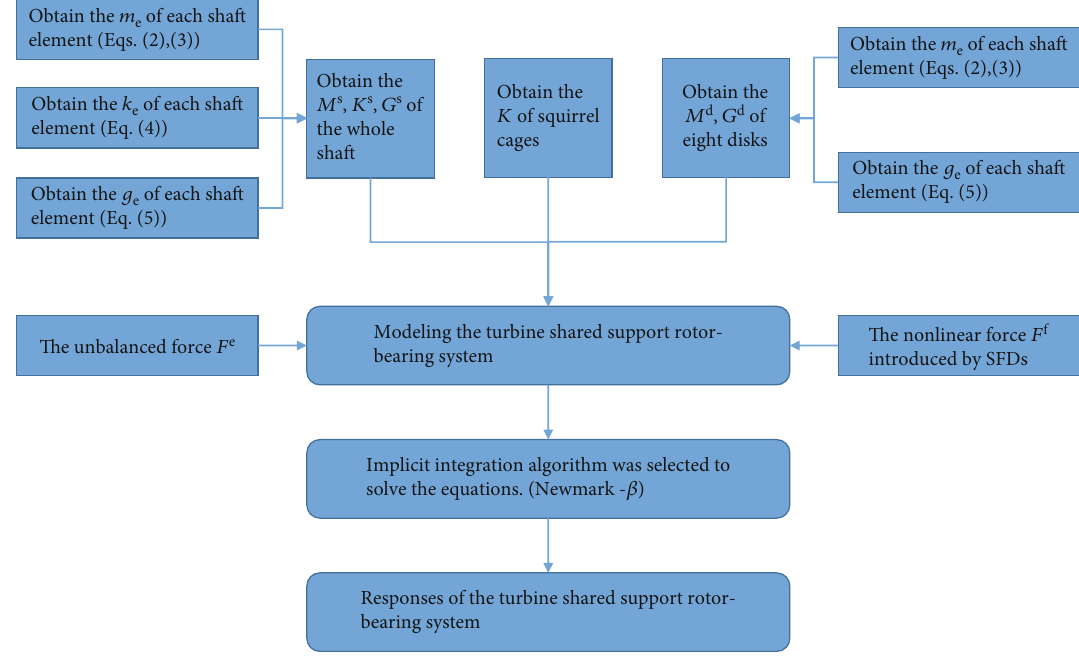
Figure 4: Flow chart of rotor-bearing system modeling and solution.